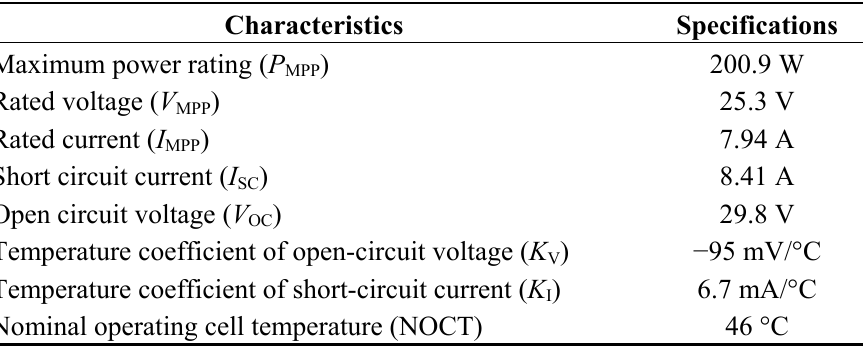
Table 2. PVT Specifications (1 kW/m 2 , 25 °